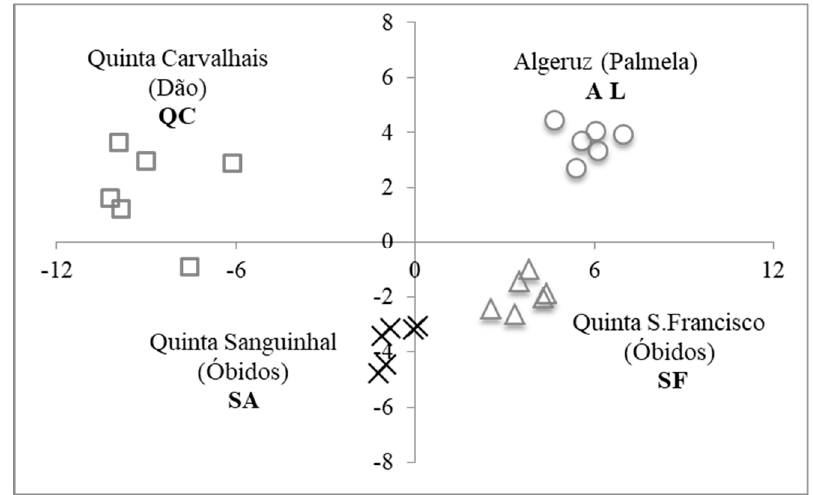
Figure 8. Scores plot of discriminant analysis (DA) of wine samples (2009 and 2010 vintages, vinification step 5) from different vineyards/DO, using Li, Mn, Rb, Sr and REE as variables.